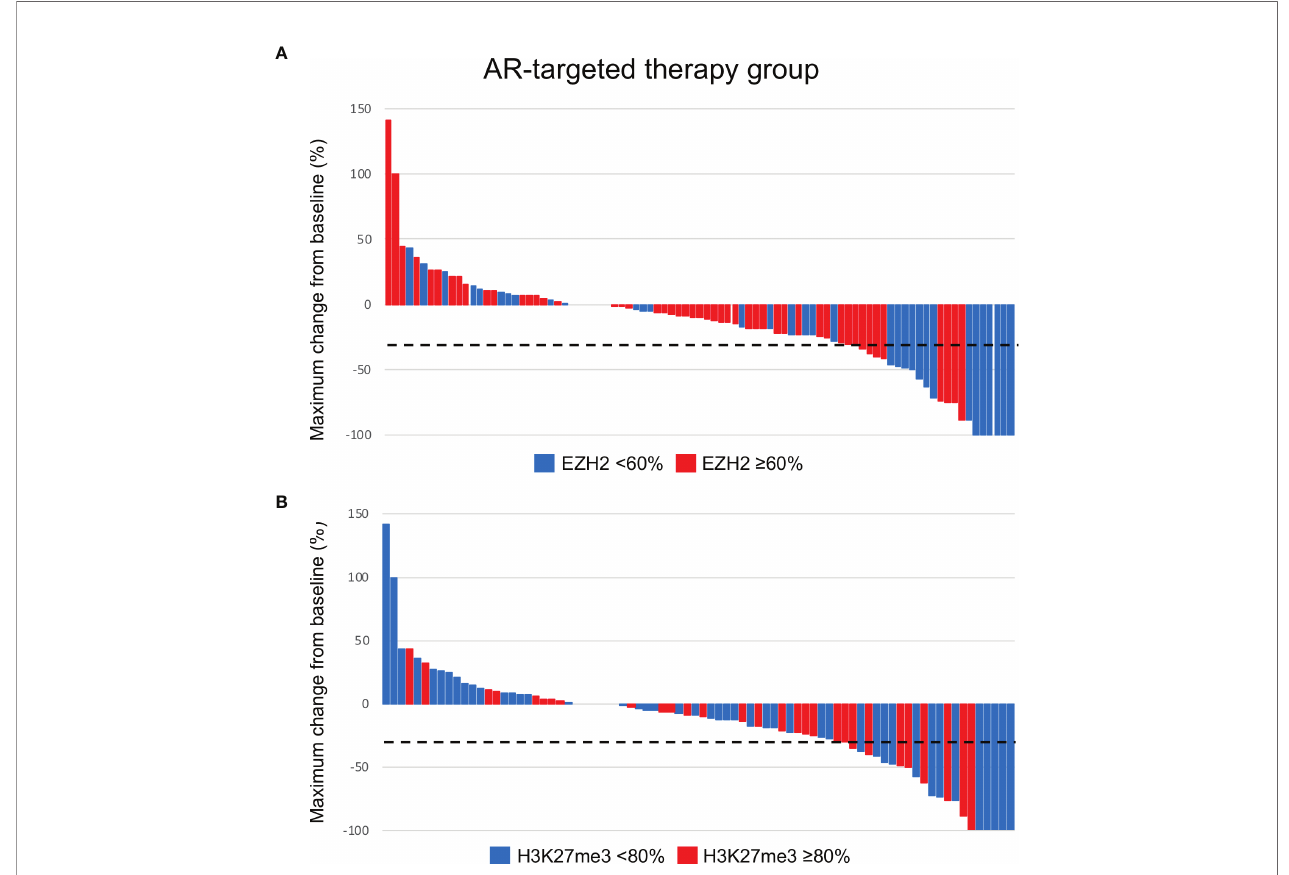
FIGURE 5 | Waterfall plots of maximum changes from baseline according to the EZH2 (A) and H3K27me3 (B) status in patients who received AR-targeted therapy. The dotted line indicates -30% of maximum change from